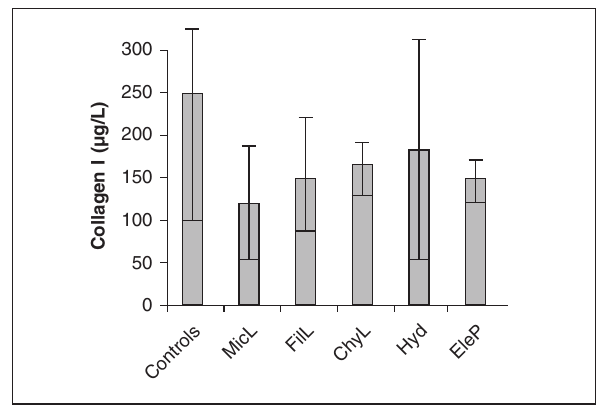
Fig. 1. – Collagen I levels, as determined by ELISA, in urine of patients with lymphatic filariasis according to their clinical status. FilL: filarial lymphangitis; ChyL: chyluria; Hyd: hydrocoele; EleP: ele- phantiasis, in comparison with controls and bacterial lymphangitis (MicL).